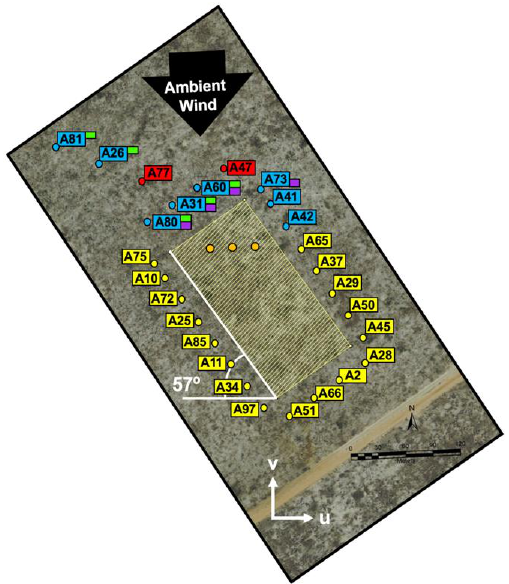
Figure 3. Layout of the S5 plot (hashed area) relative to the ambient wind. The plot was instrumented with 27 anemometers shown as yellow, blue or red numbered circles. Blue and red circles indicate anemometers considered upwind relative to the ambient wind on the day of the burn. Green flags mark anemometers included in the 5-sensor average, while purple flags mark anemometers included in 4-sensor average. Orange circles mark the center and ends of the ignition line. For each sensor n and each point in time after ignition, we calculated orthogonal wind velocity components, 𝑢 𝑛 and 𝑣 𝑛 , using Equation (1):